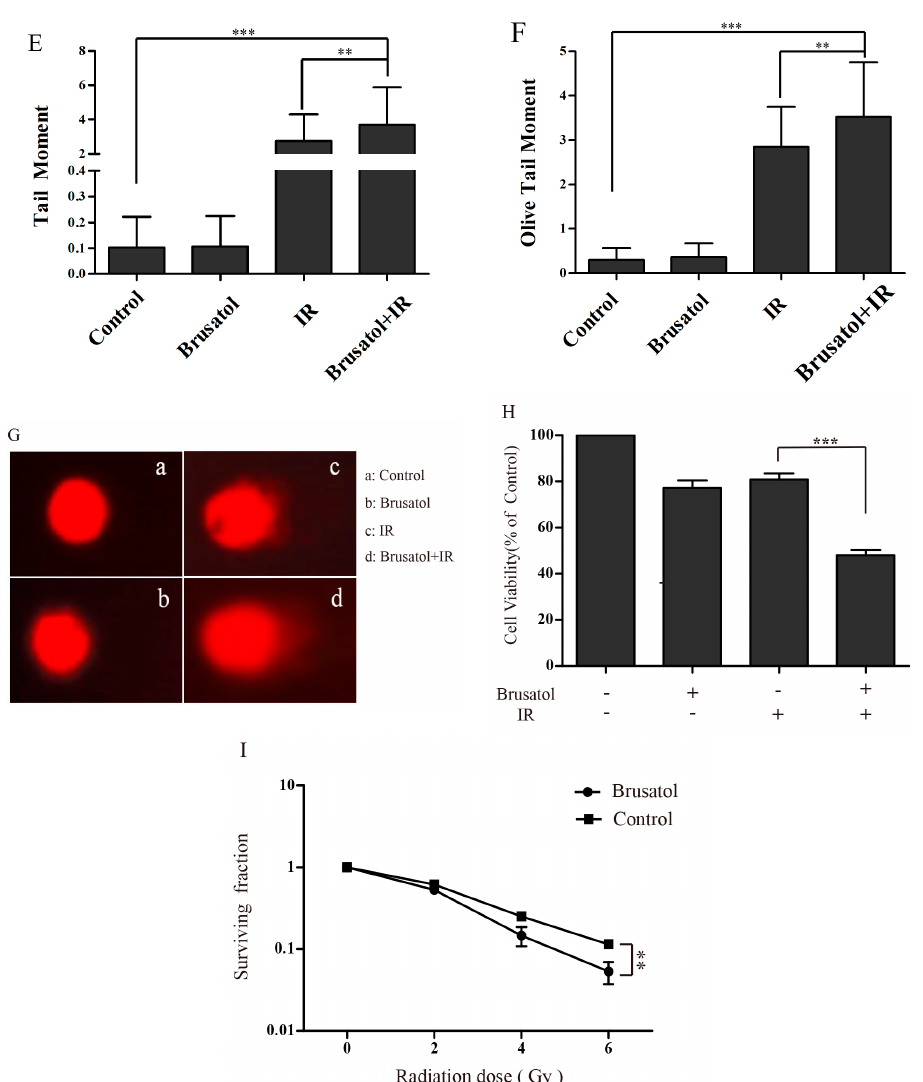
Figure 3. Brusatol enhances the radiosensitivity of A549 cells. ( A , B ) Detection of ROS levels by the fluorescence indicator H2DCFH-DA 6 h ( A ) or 24 h ( B ) after exposure to 6 Gy γ -irradiation, using flow cytometry (FCM); ( C – G ) Detection of DNA damage by comet assay; ( H ) A549 cells were treated with or without 80 nM brusatol for 4 h, then were exposed to 10 Gy γ -irradiation or not. 24 h later, cell viability was measured by MTT assay; ( I ) A549 cells were treated with, or without, 80 nM brusatol for 4 h, then were exposed to the indicated dose of γ -irradiation. Colonies containing more than 50 cells were counted 1–2 weeks later. *** p < 0.001, ** p < 0.01, * p < 0.05. Data from clonogenic survival assays and MTT assays revealed that brusatol enhanced the radiosensitivity of A549 cells (Figure 3H,I). During cell culture, we found that IR alone could significantly inhibit cell proliferation, but did not have the same effect on cell survival, which increased even greater than that of the control group. However, when treated with both brusatol and IR, cell proliferation is halted, to a degree much less than that of the control cells, eventually leading to gradual death. This phenomenon could also be found in the Immunofluorescence (Figure 2G).